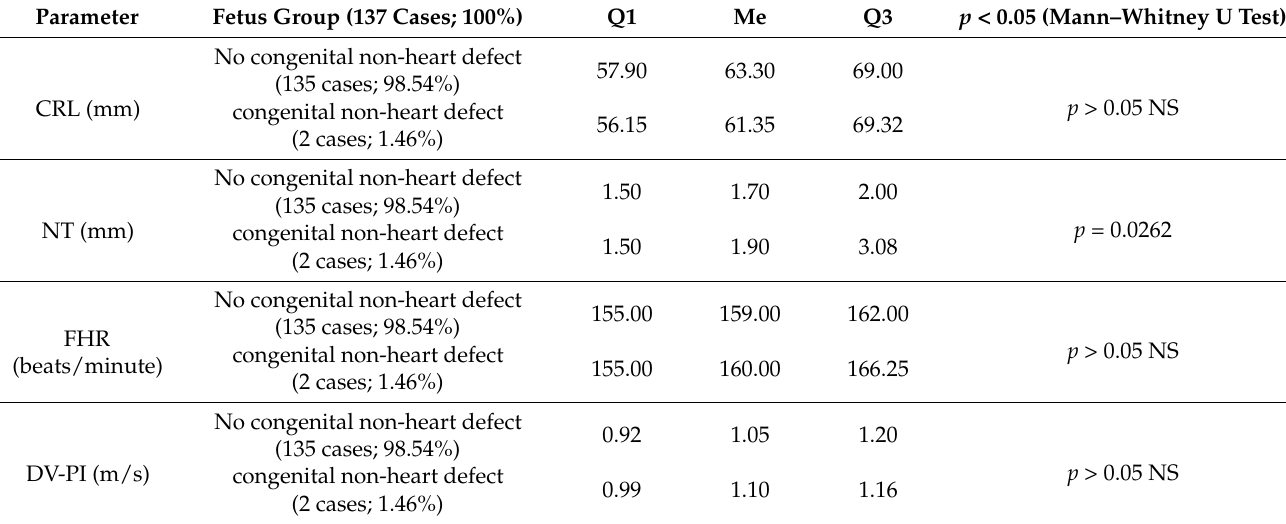
Table 6. Assessment of parameters describing the growth and health of the fetus with determined non-heart developmental defects or after the exclusion of their possibility based on ultrasound examination in the group of women who became pregnant after the induction of ovulation as a result of sexual intercourse.